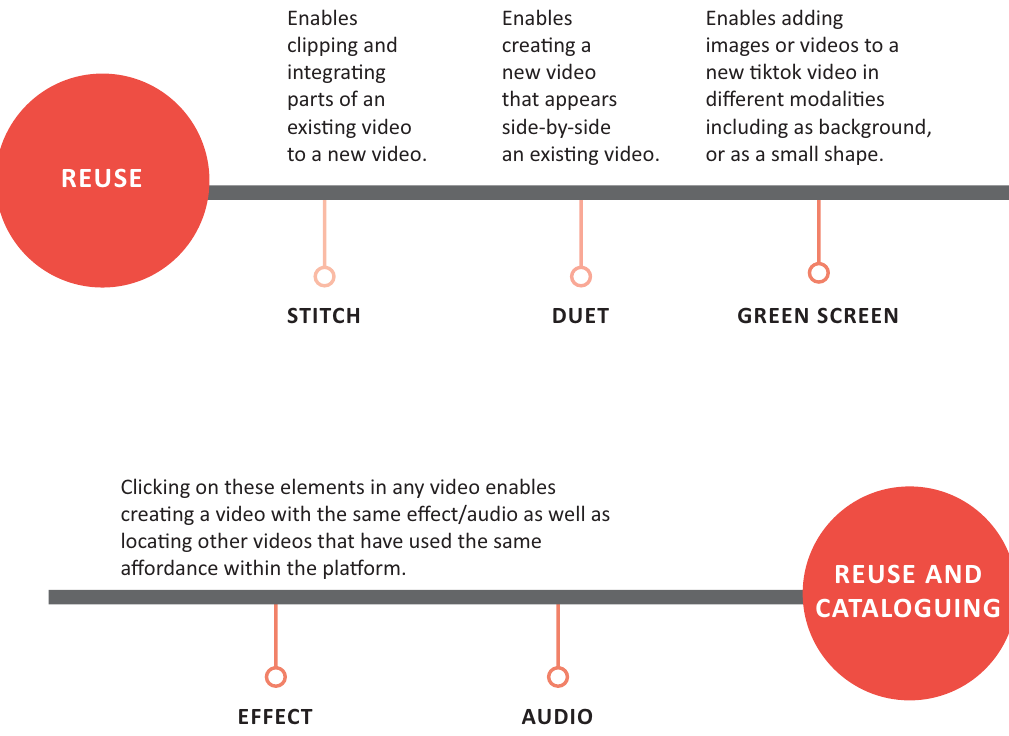
Figure 1. TikTok’s content reuse and cataloguing possibilities of interest for this study (not comprehensive). Media and Communication, 2022, Volume 10, Issue 1, Pages